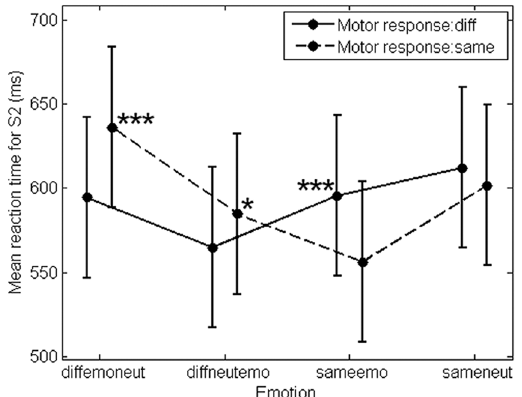
Figure 1. Behavioral analyses. Interaction between emotion and motor response. Stars represent simple effects’ results comparing a motor response repetition to a motor response alternation for each level of the emotion factor. *** Corresponds to a significance level of 0.001 and * To a significance level of 0.05. Vertical bars represent confidence intervals of